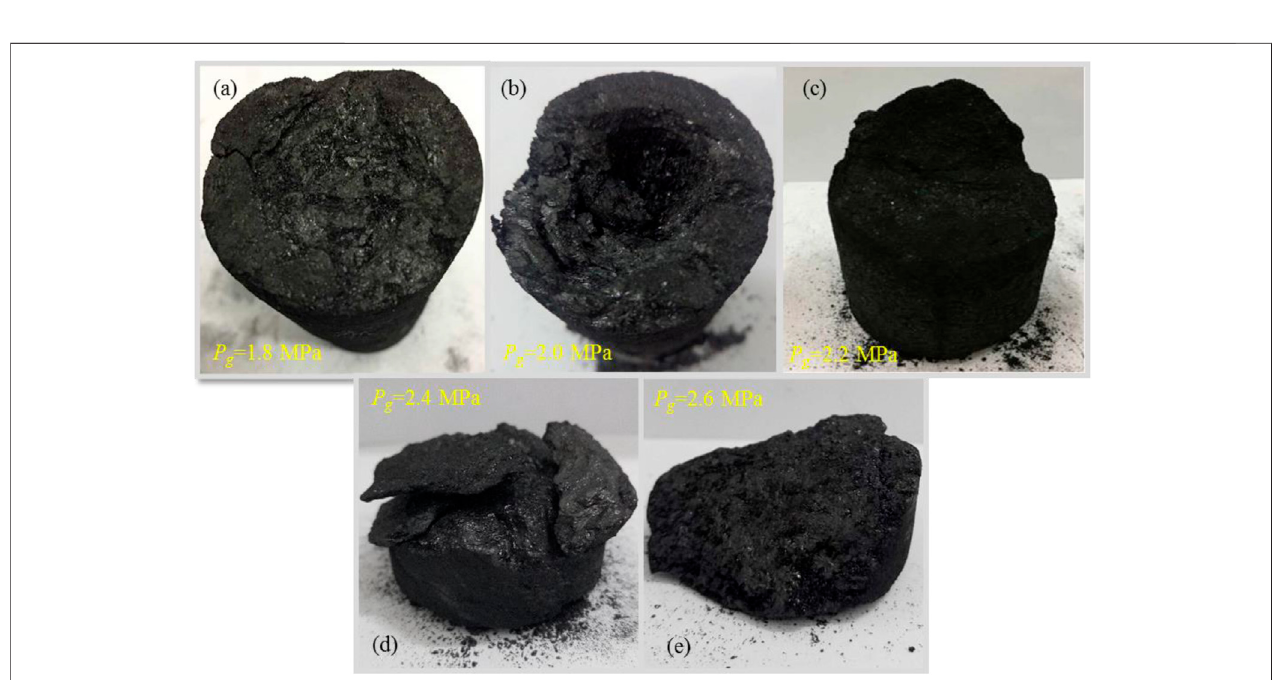
FIGURE7| Partofcoalsamplesmaintainingarelativelycompleteshapeafteroutburstunderdifferentgaspressuresfrom1.8to2.6 MPa.Coalsamplesfor1.2and 1.6 MPa were basically unchanged and are not presented here.